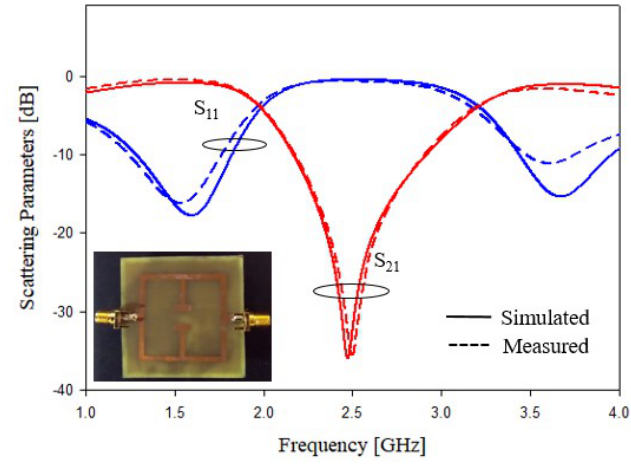
Figure 16. Experimental assessment, T-shapes stubs, prototype of Figure 5b. Comparisons between numerical and measured scattering parameters.